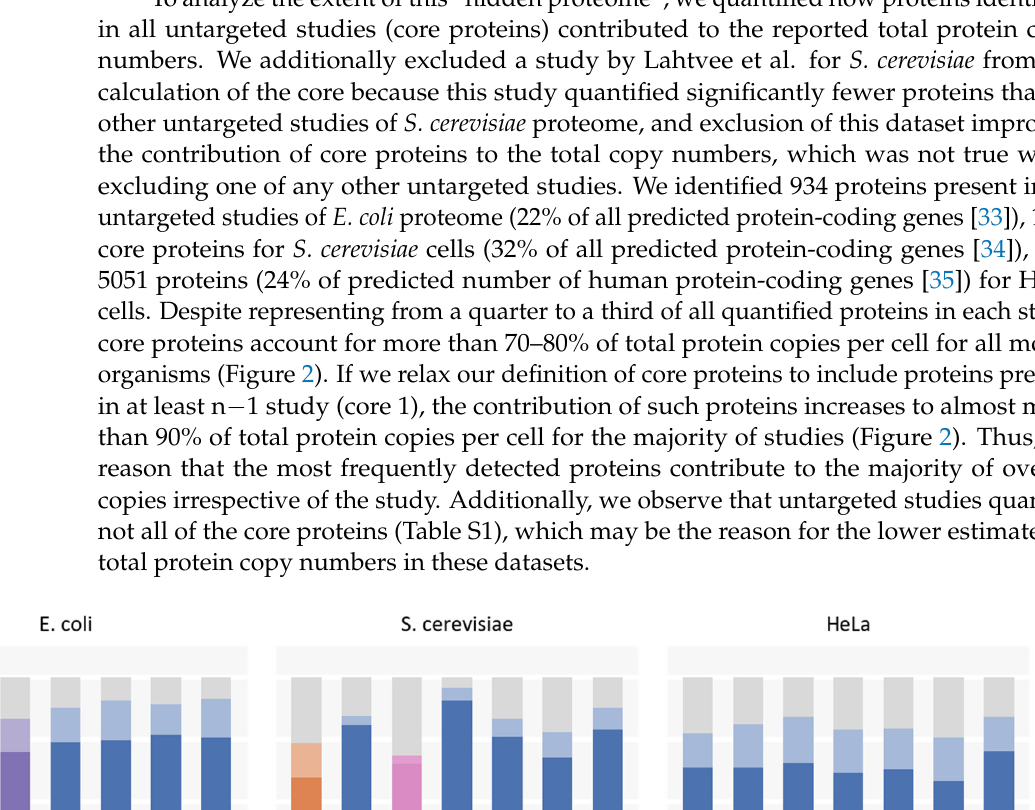
Figure 3. Normalized expression of most and least commonly detected proteins. Proteins per mil- lion denote protein copy number divided by the sum of all protein copies in the dataset and multi- plied by a million. To explore the possible discrepancies in quantification of individual proteins, we cal- culated pairwise Pearson’s correlation for selected datasets (Figure 4). The overall levels of correlation are moderate (mean Pearson’s r = 0.63 for E. coli , 0.57 for S. cerevisiae, and 0.70 for Hela cells). Moderate levels of pairwise correlations are typical for mass spectrom- etry-based experiments, although, of course, a better level is expected since identical cell types in almost identical conditions are considered. Interestingly, a targeted immunoblot- based study of S. cerevisiae by Ghaemmaghami et al. demonstrated lower-than-average levels of correlation with mass spectrometry studies. Additionally, a fluorescence-based